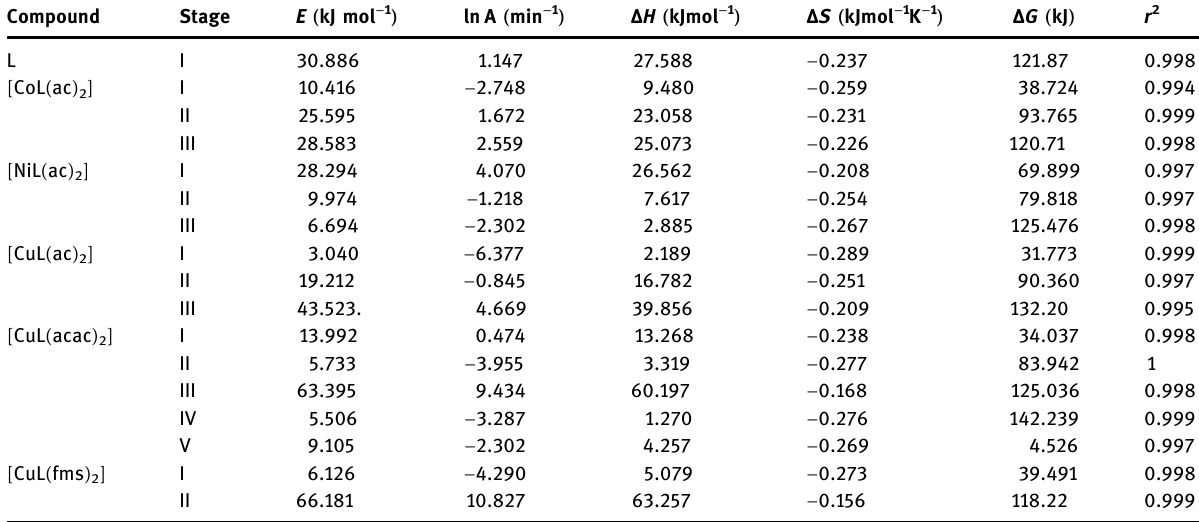
Table 5: Thermal kinetic parameters of the ligand and its metal complexes Compound